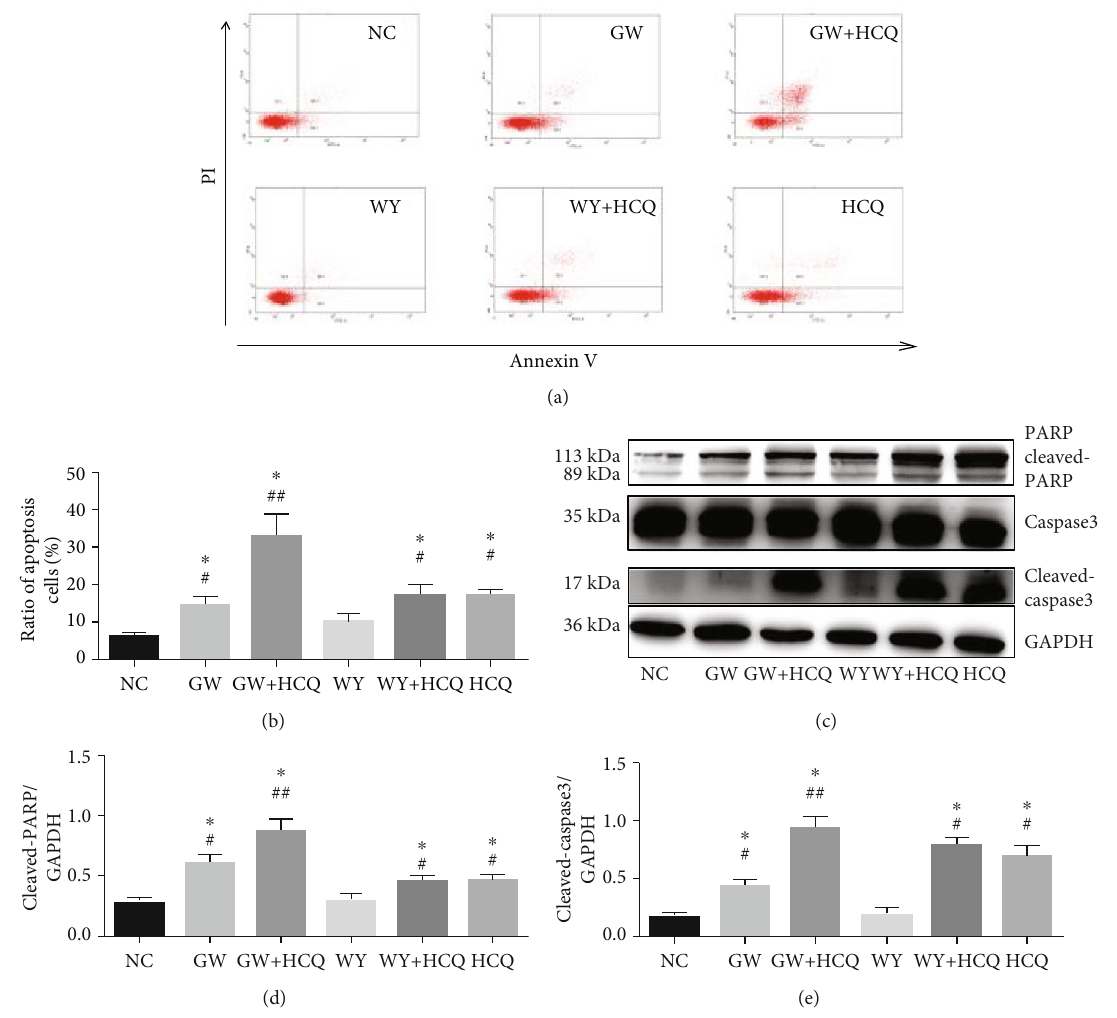
Figure 5: On cotreatment of hydroxychloroquine and GW6471, the ratio of apoptotic cells was promoted in 786-O cells. (a) Flow cytometry was performed for detecting apoptotic cells. (b) Ratio of apoptotic cells was calculated by fl ow cytometry. (c) The expression of cleaved-PARP and cleaved caspase-3 was analyzed by western blotting. (d) Semiquanti fi cation of cleaved-PARP normalized by GAPDH. (e) Semiquanti fi cation of cleaved caspase-3 normalized by GAPDH. ( n = 3 , one-way ANOVA with LSD ∗ P < 0 : 05 , # compared with untreated group, ## compared with group of GW6471).